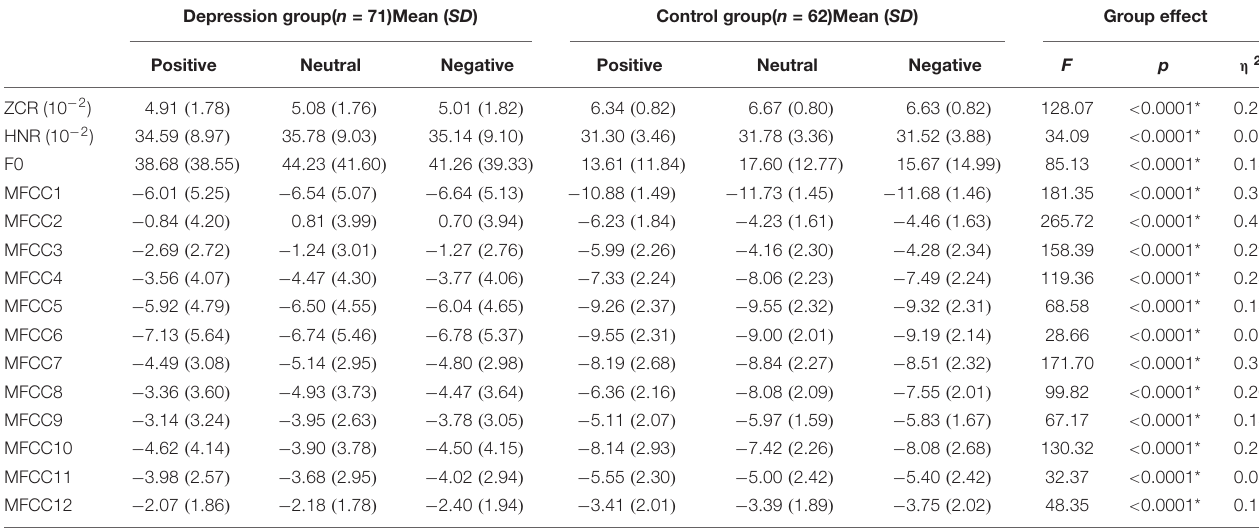
TABLE 2 | Differences in acoustic characteristics between the depression and control groups under different emotional tasks N = 133. Depression group( n = 71)Mean ( SD ) Control group( n = 62)Mean ( SD ) Group effect